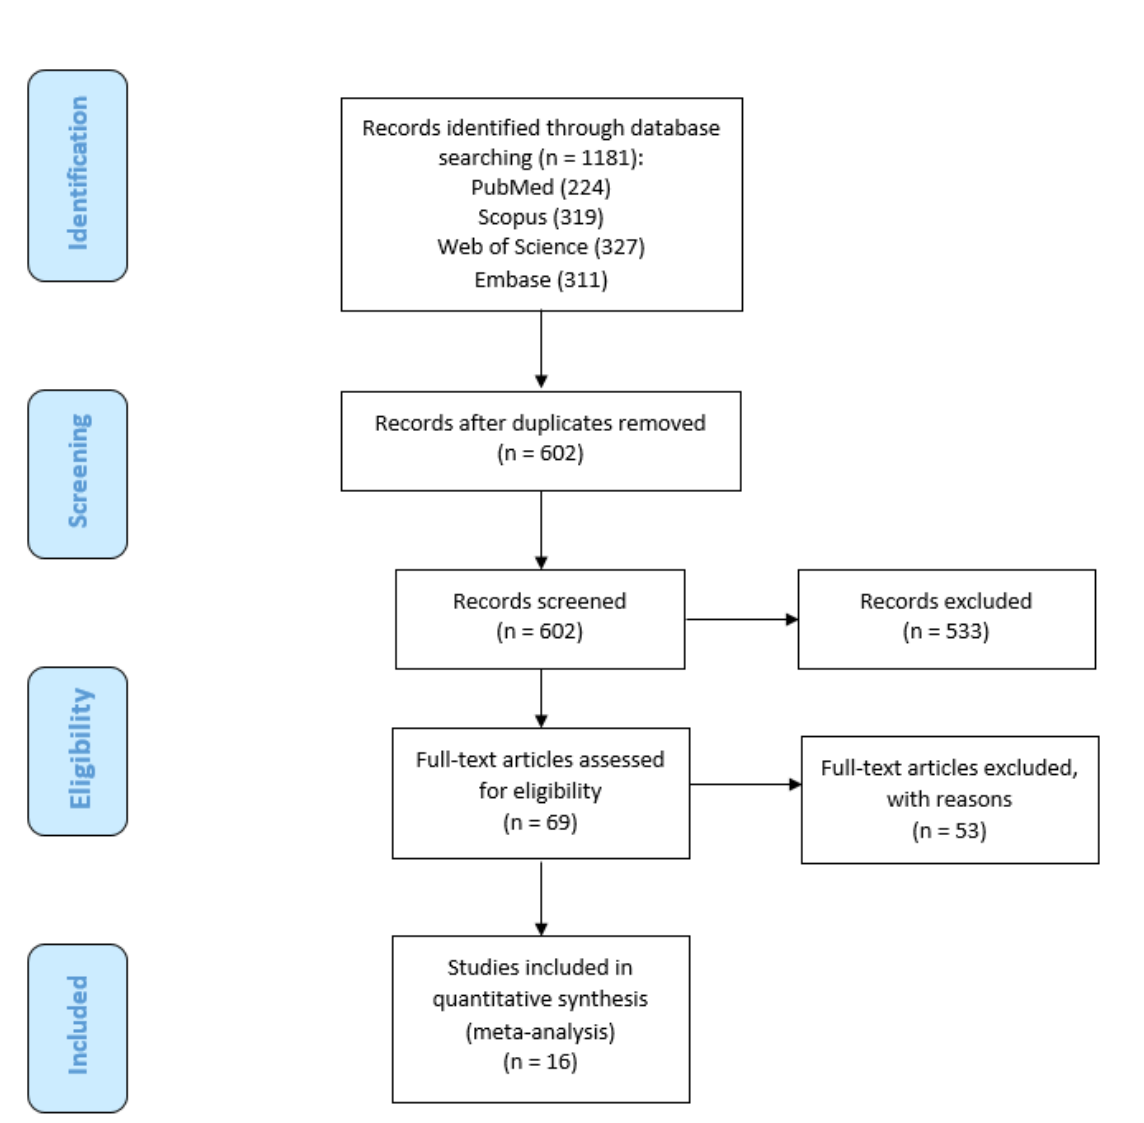
Figure 2: The PRISMA flowchart of study identification and selection